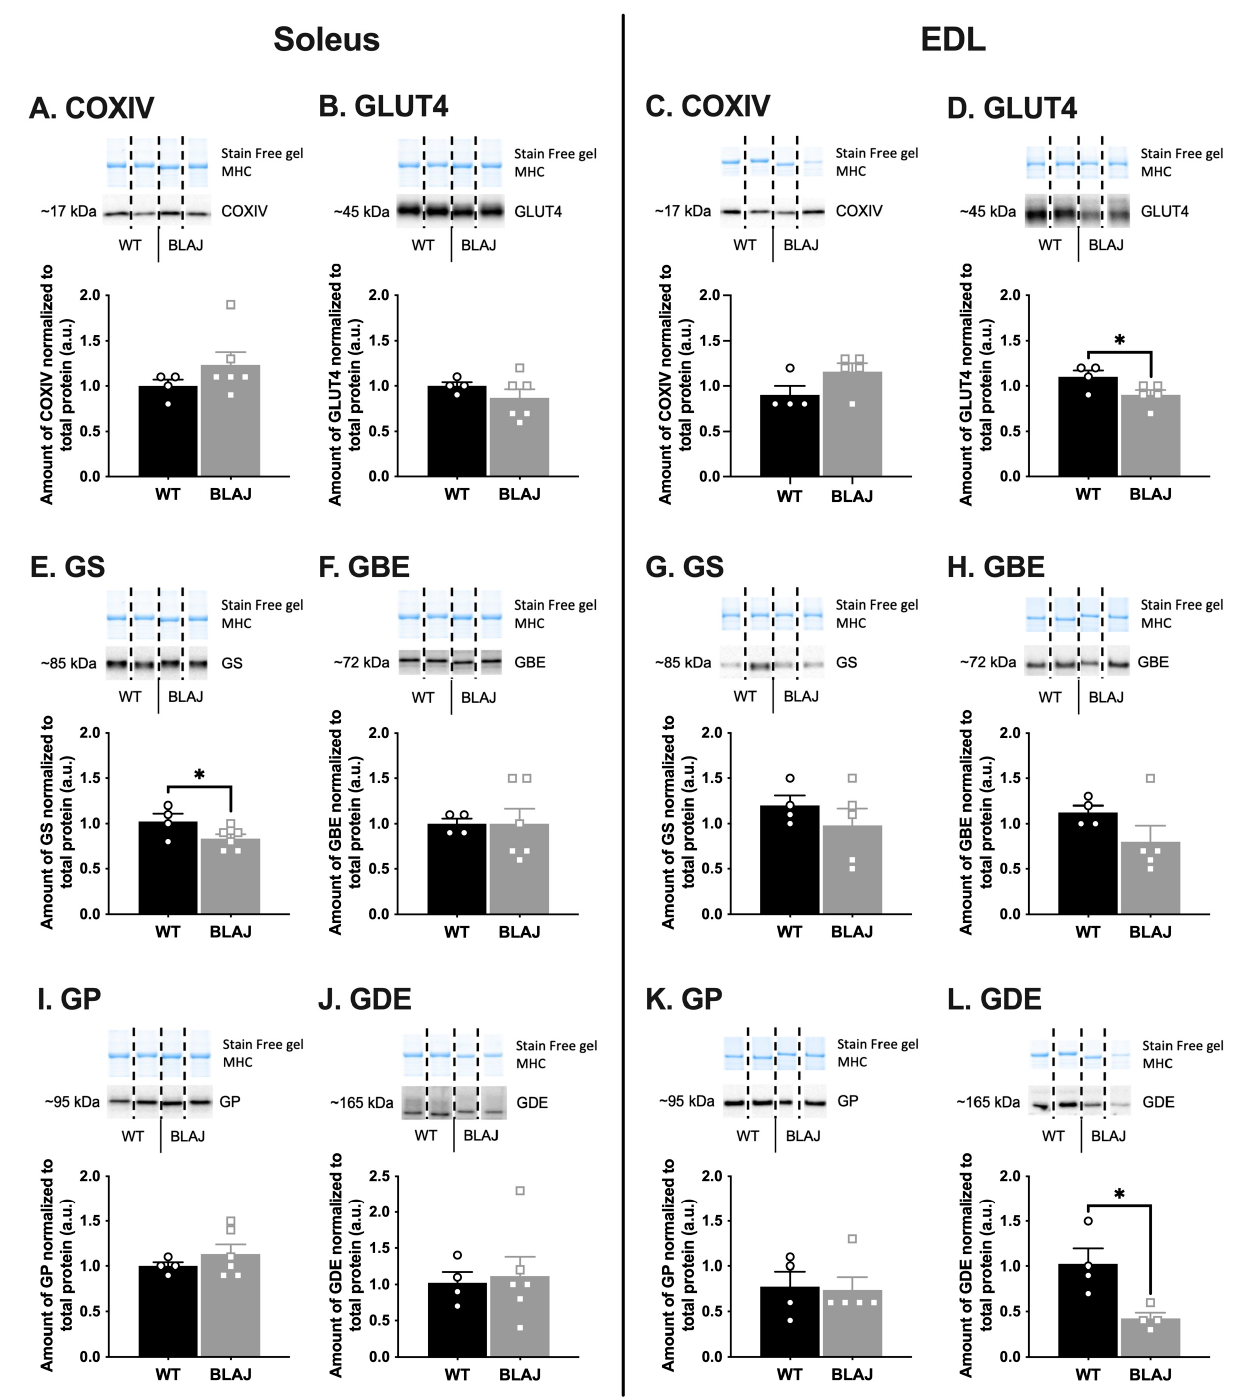
Figure 2. The levels of proteins associated with glucose/glycogen metabolism in soleus and EDL muscles, of WT compared with dysferlin ‐ deficient BLAJ male mice aged 10 months. Whole muscle homogenates analyzed by Western blot. ( A , C ) Cytochrome c oxidase subunit IV (COXIV). ( B , D ) Glucose transporter type 4 (GLUT4); ( E , G ) Glycogen synthase (GS); ( F , H ) Glycogen branching enzyme (GBE); ( I , K ) Glycogen phosphorylase (GP); ( J , L ) Glycogen debranching enzyme (GDE). Data analyzed by Student’s t ‐ test: * BLAJ vs WT ( p < 0.05). Data are presented as individual values (WT as circles, BLAJ as squares) and mean ± SEM ( n = 4–6), with representative Western blots where non ‐ contiguous lanes from the same gel are separated by black dashed lines.